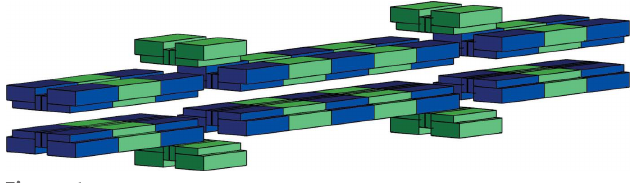
Figure 1 Section of the QMSC insertion device (EPU 180 mm) to illustrate the magnet